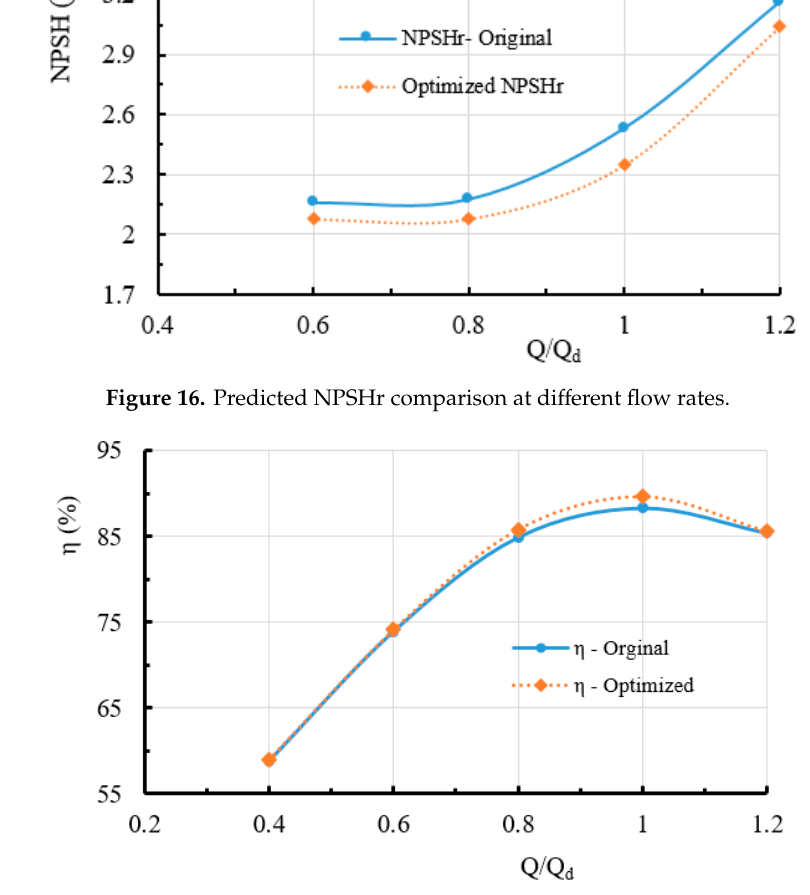
PS Figure 18. Comparison of static pressure distribution in impeller blade surface.